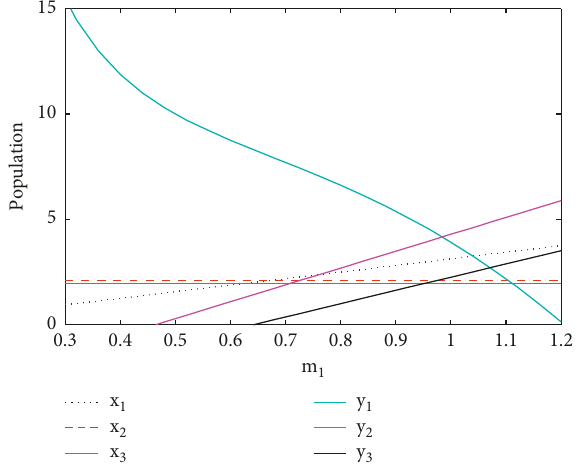
� m � m on the system (1). 1 2 3